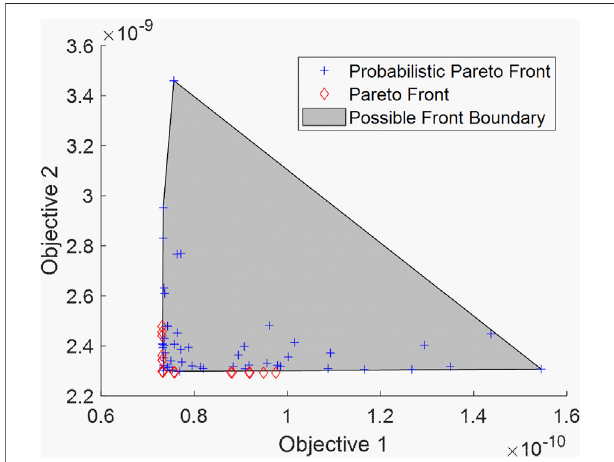
FIGURE 7 | Probabilistic Pareto front (note: the Pareto front boundary is roughly estimated).